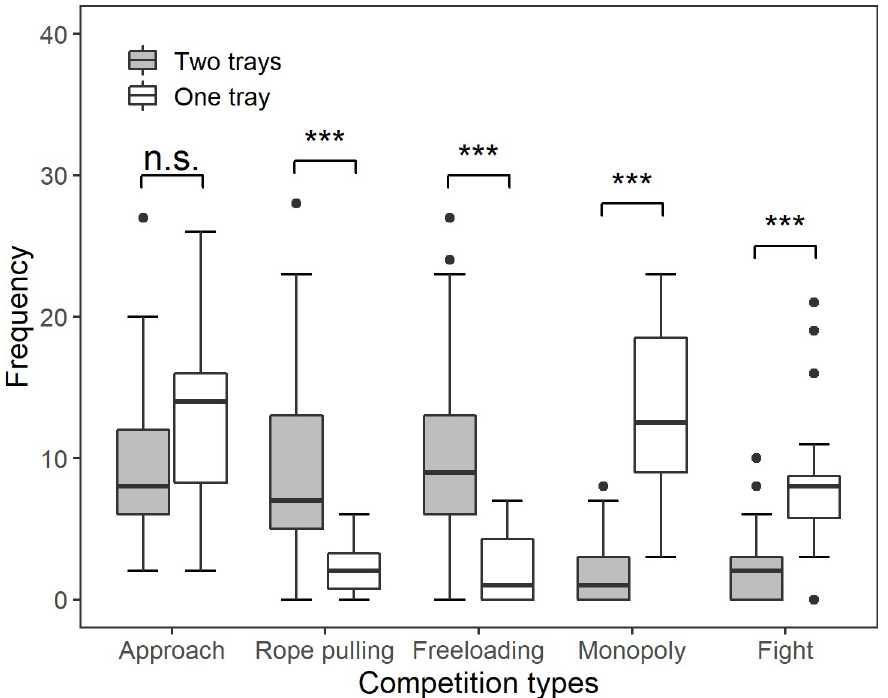
Fig 4. Comparison of competition behavior frequencies between 2-tray and 1-tray phases. The bold line inside each box is the median frequency per session of each competition behavior. The top whisker representsthe maximum frequency, while the bottom whisker representsthe minimum frequency (excluding outliers). Upper and lower quartiles are represented by the top and bottom edge of the box, respectively. The black data points above the top or below the bottom whisker are outliers. Asterisks represent significant differences between the frequency of behaviors between the 2-tray and 1-tray conditions ( ��� P < 0.001; n.s. P > 0.05). The data used to generate this figure can be found in S1 Data.